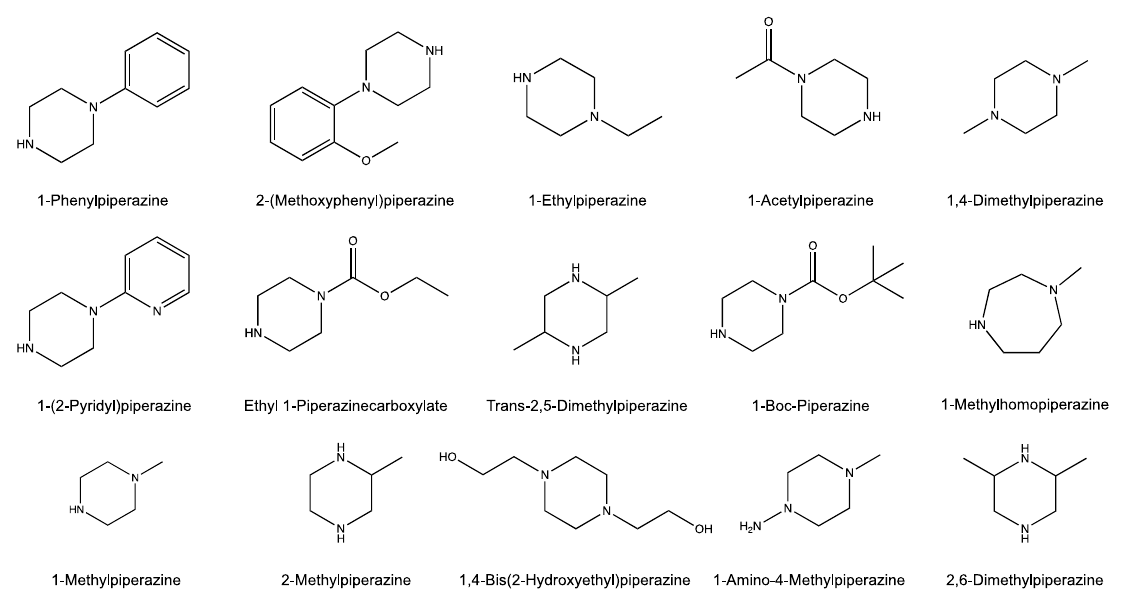
Figure 2. Chemical structure of substituted piperazines. Substituted piperazines: 1-phenylpiperazine, 2-(methoxy- phenyl)piperazine, 1-ethylpiperazine, 1-acetylpiperazine, 1,4-dimethylpiperazine, 1-(2-pyridyl)piperazine, ethyl-1-piper- azinecarboxylate, trans-2,5-dimethylpiperazine, 1-boc-piperazine, 1-methylhomopiperazine, 1-methylpiperazine, 2- methylpiperazine, 1,4-bis(2-hydroxyethyl)piperazine, 1-amino-4-methylpiperazine, and 2,6-dimethylpiperazine.